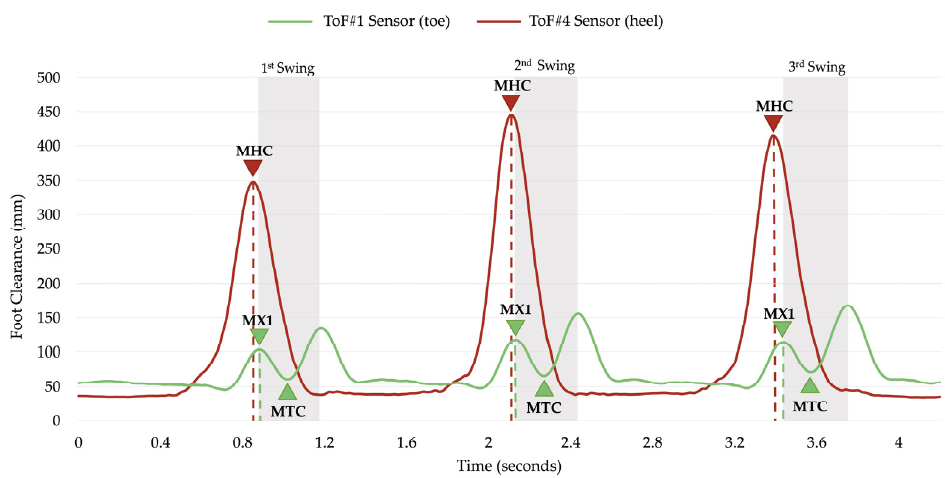
Figure 4. A sample of the distance signals collected from ToF#1 sensor and ToF#4 sensor for a 3-step trial captured from one participant during normal walking speed. The grey shaded area represents the swing phase of the gait cycle.